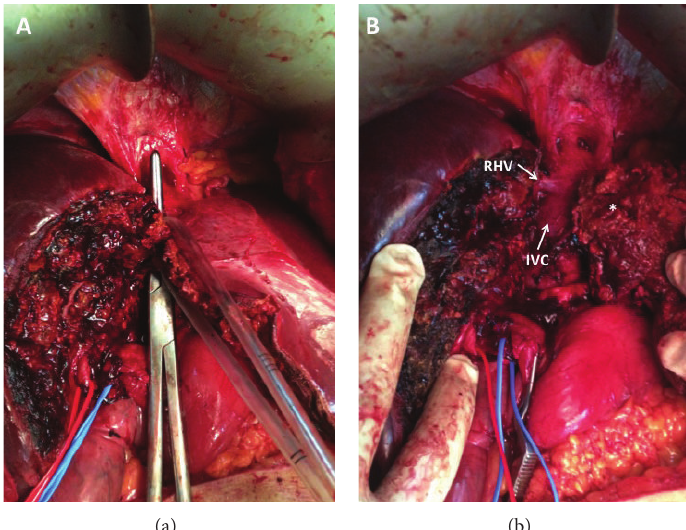
Figure 7: (a) The parenchyma was transected right down to the IVC and allowed the RHV to be preserved in order to maintain outflow from the future liver remnant.